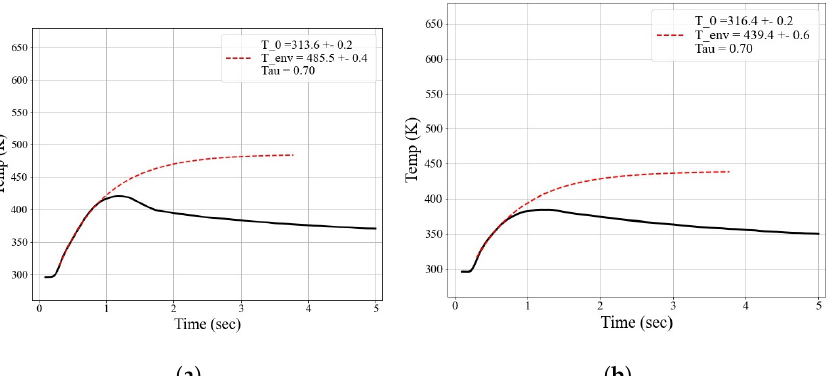
Figure 9. Extrapolated total temperature at 500 K plenum setting and P 0 = 1.6 bar for ( a ) Valves on ( b ) Valves off.